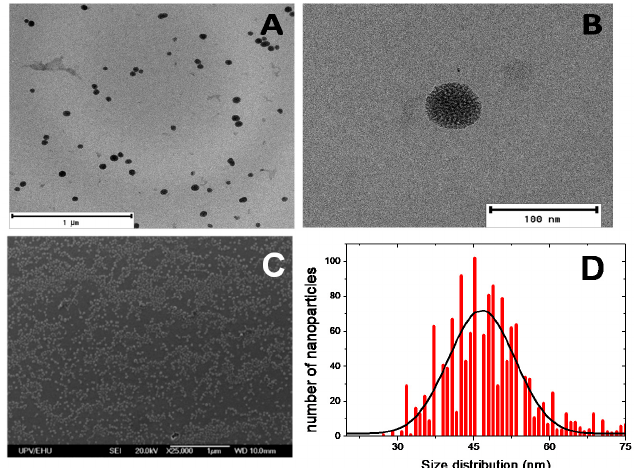
Figure 2. Transmission electron microscopy (TEM) images ( A , B ), scanning electron microscopy (SEM) image ( C ) and size distribution ( D ) of mesoporous silica nanoparticles (MSNs).